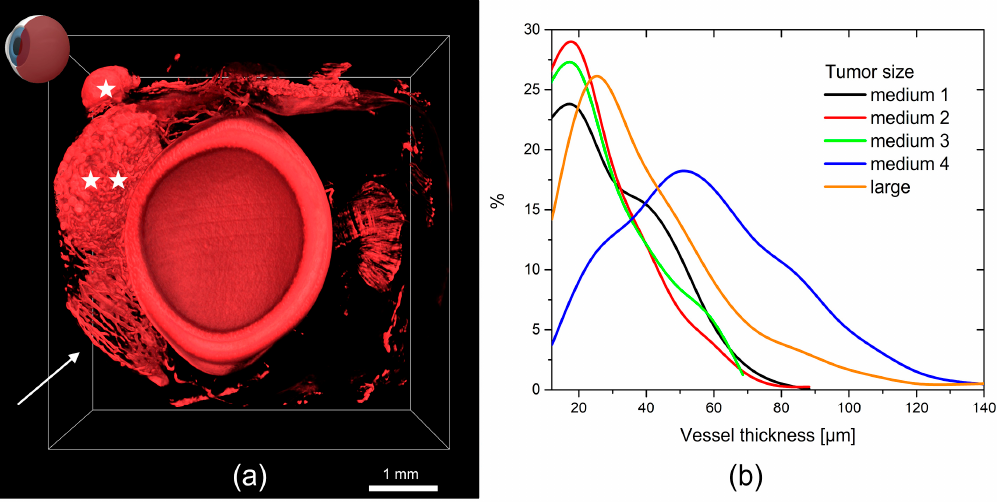
Figure 6. ( a ) micro-CT image of the vascular structures of a medium-sized BHM melanoma with lens. ( ★ ) Extraocular extension of an intraocular melanoma. ( ★★ ) Medium-sized tumor vascularization. The arrow points to the structure of a normal iris vasculature; ( b ) distribution of the vessel size in the eyeballs with BHM tumors.